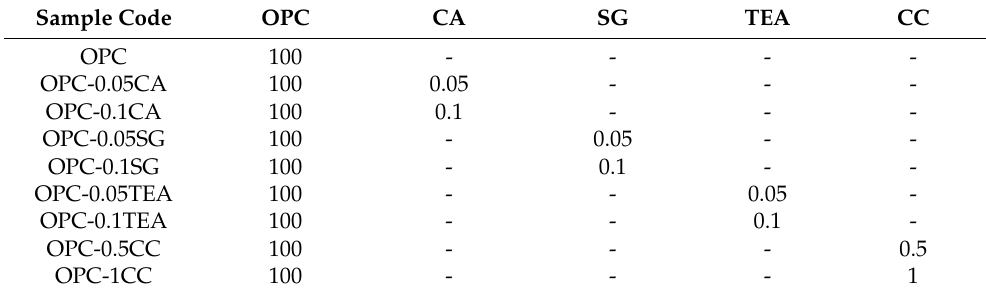
Table 1. The oxide compositions of the cement (%).